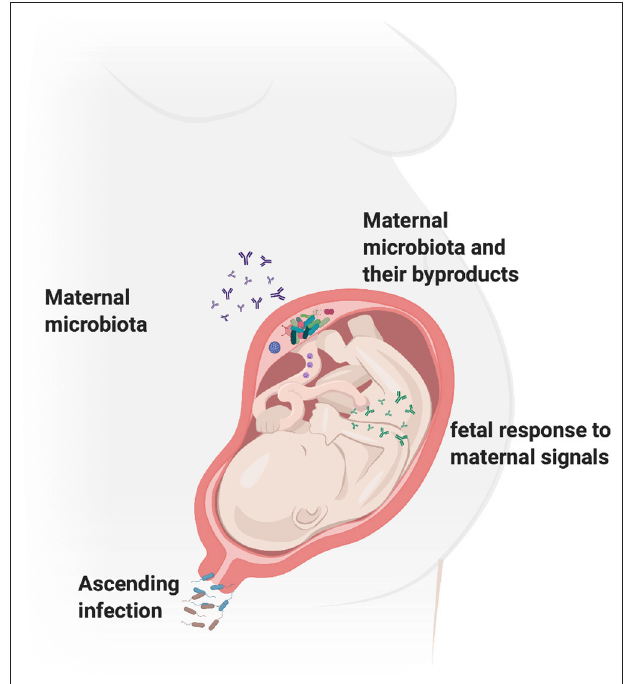
FIGURE 3 | Gestational environment shapes fetal programming. The pregnant vaginal microbiome is known to consist of more than 170 species and studies suggest that the vagina might be a source of microbes for the fetus via vertical transmission in utero or parturition. Maternal microbiome at sites such as the gut and the oral cavity have also been shown to contribute to the development of normal fetal microbiome and mucosal immunity. Bacteria, their metabolites and other by-products have been isolated in the placenta and are also shown to shape fetal immune development post-birth. Thus, the maternal microbiome can impact the fetal development via several mechanisms including altering the maternal inflammation, as well as mediating direct effects on fetal genetics. Figure created using the BioRender